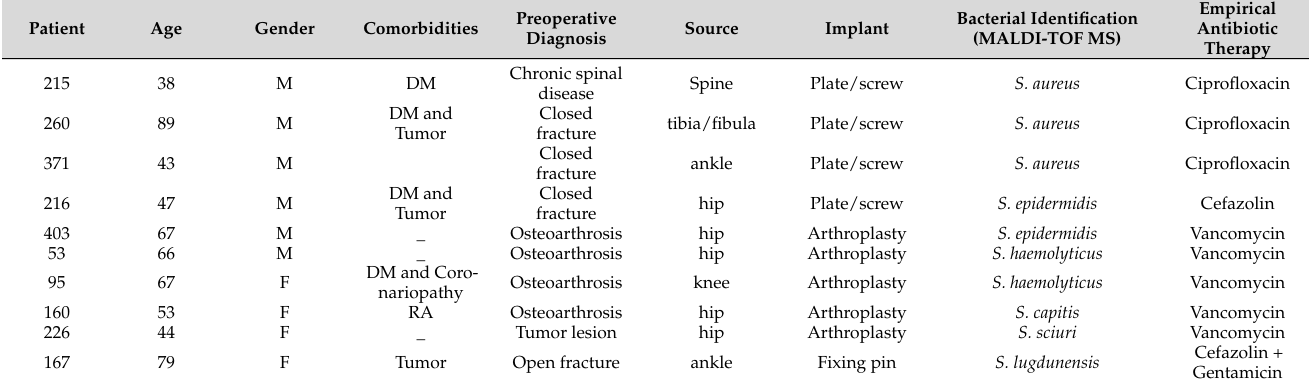
F: female gender; M: male gender; DM: diabetes melitus; RA: rheumatoid arthritis; MALDI-TOF MS: Matrix- assisted laser desorption/ionization time-of-flight mass spectroscopy.